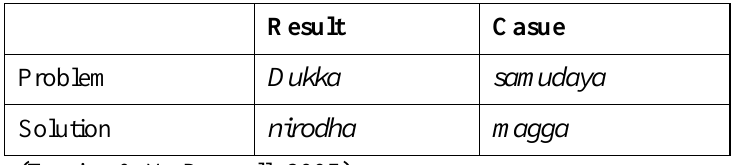
Table 01: Cause and